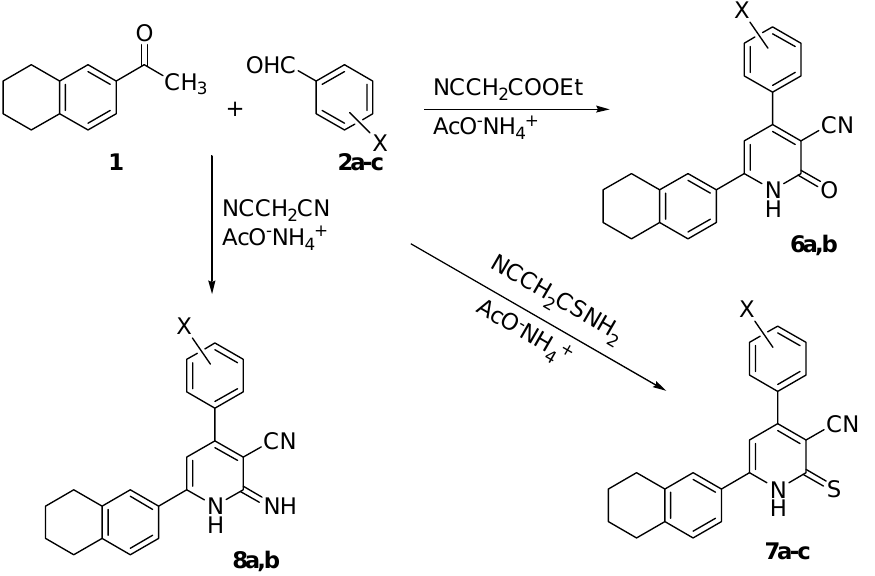
Yield Molecular Formula Cryst. Solv. (%) (Mol.